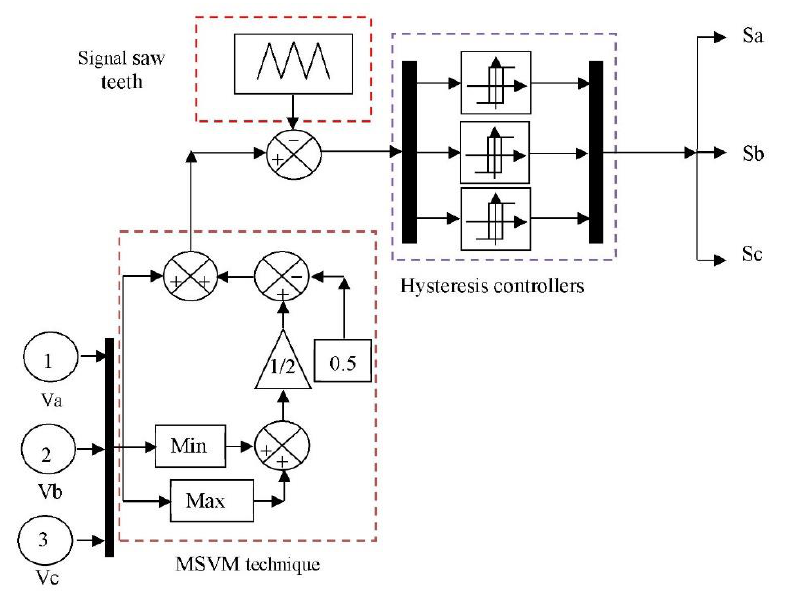
Figure 1. Modified SVM technique.